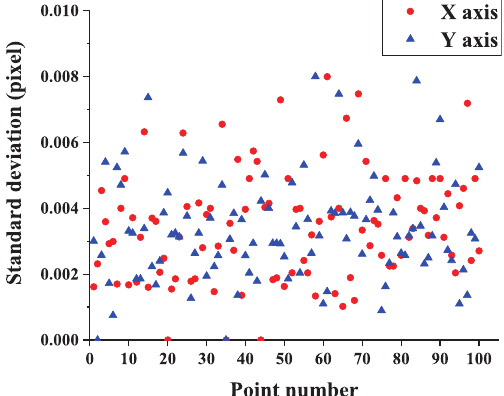
Figure 14. Standard deviations of image points pixel